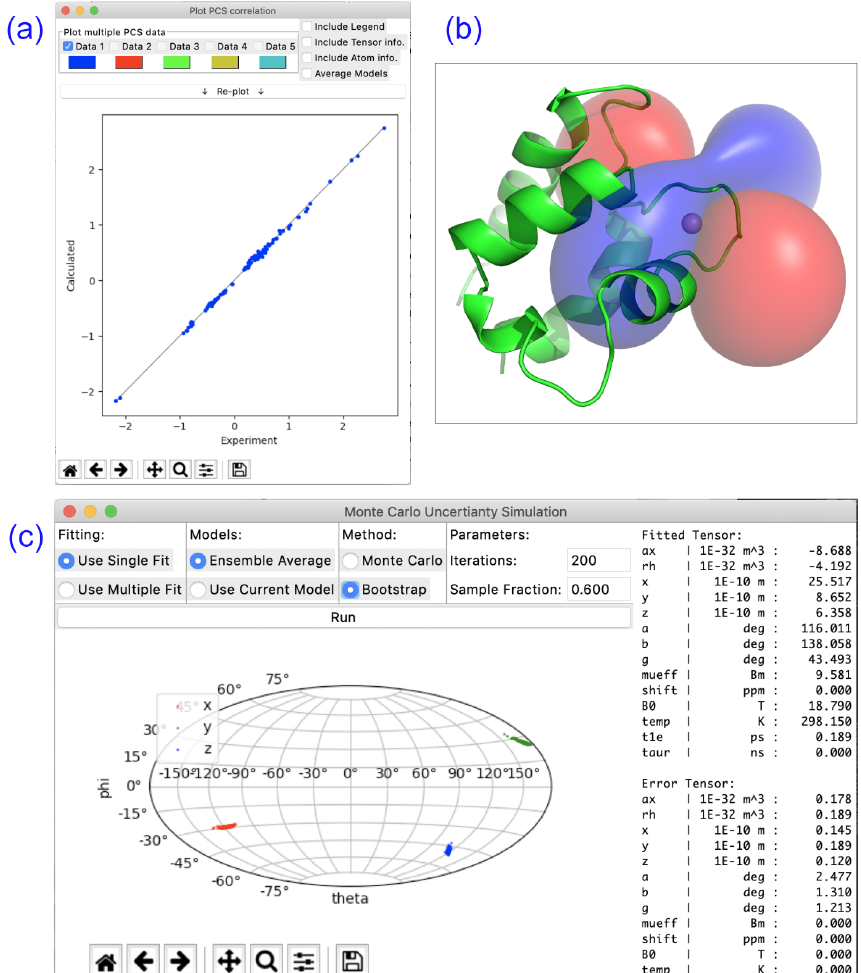
Figure 2. Plotting options available in Paramagpy illustrated with data of calbindin D 9k loaded with Er 3 + . (a) Correlation plot of calculated versus experimental PCS values after fitting of the (cid:49)χ tensor. (b) PCS isosurface plot viewed in PyMOL. (c) Sanson–Flamsteed plot showing the principle axes projections after bootstrap analysis. “Error Tensor” reports the standard deviation in fitted